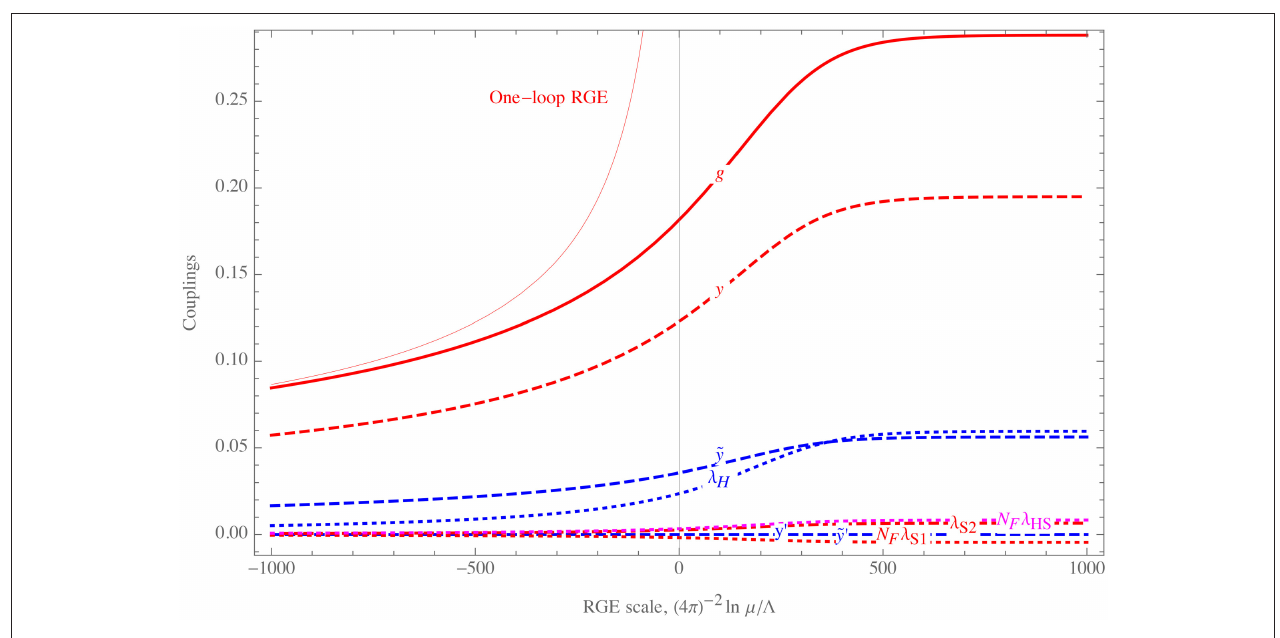
FIGURE 2 | Illustration of a possible RGE running with N c